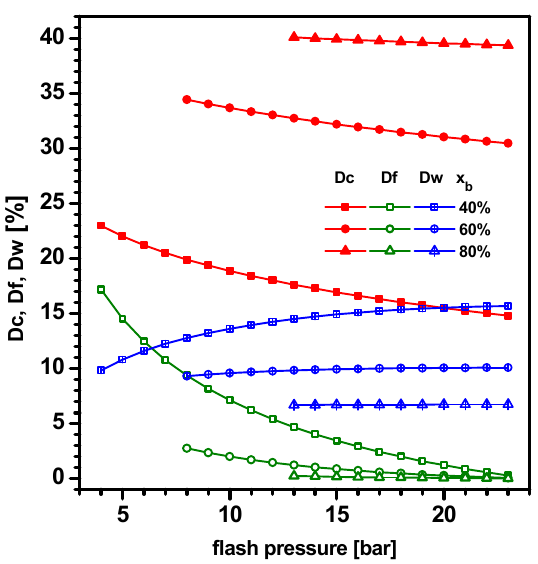
Figure 3. Dependence of Dc , Df , and Dw on the flash pressure for some values of x b .